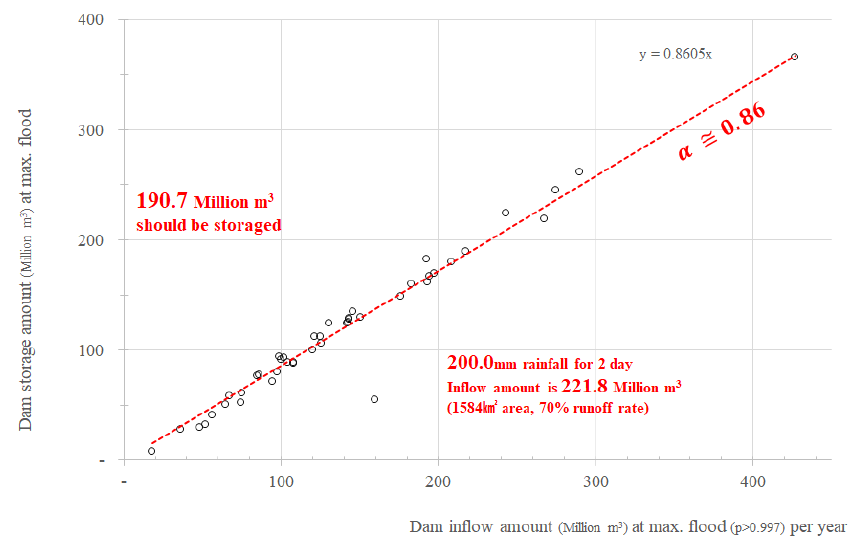
Figure 5. Predischarge operation concept at flood event with RSF, red dot line indicats RSF curve and blue dot line represents the process to estimate flood control capacity.